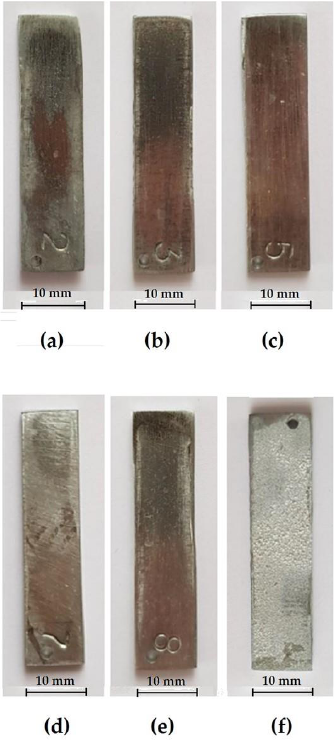
Figure 9. Appearance of zinc samples modified with formulations based on organosilanes after accelerated corrosion tests in the climate chamber, ( a ) — non-modified metal; zinc modified with: ( b ) — 1% aqueous solution of VS; ( c ) — aqueous solution of (1% VS + 1% AS) mixture; ( d ) — neutral 1% aqueous solution of GS; ( e ) — neutral 1% aqueous solution of AS; ( f ) — acid 10% aqueous solution of GS with addition of acetic acid (рН 4.0), T = 60 °C, RH = 95%, test duration 60 days.